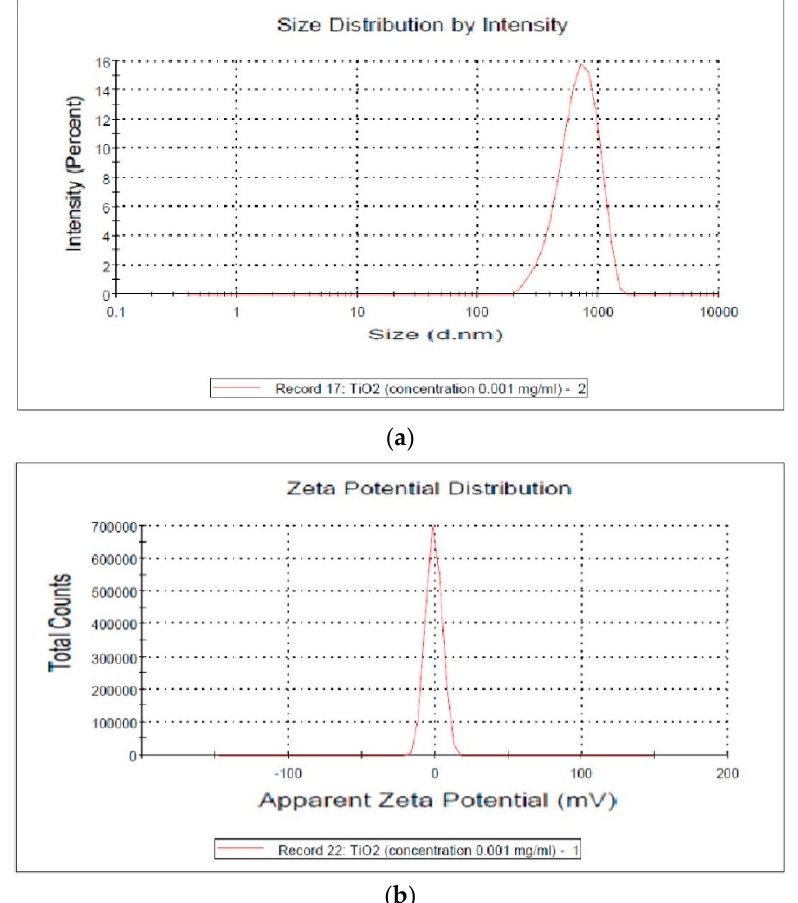
Figure 3. ( a , b ) Zeta size distribution and potential of titanium nanostructuresTiO 2 -NPs.